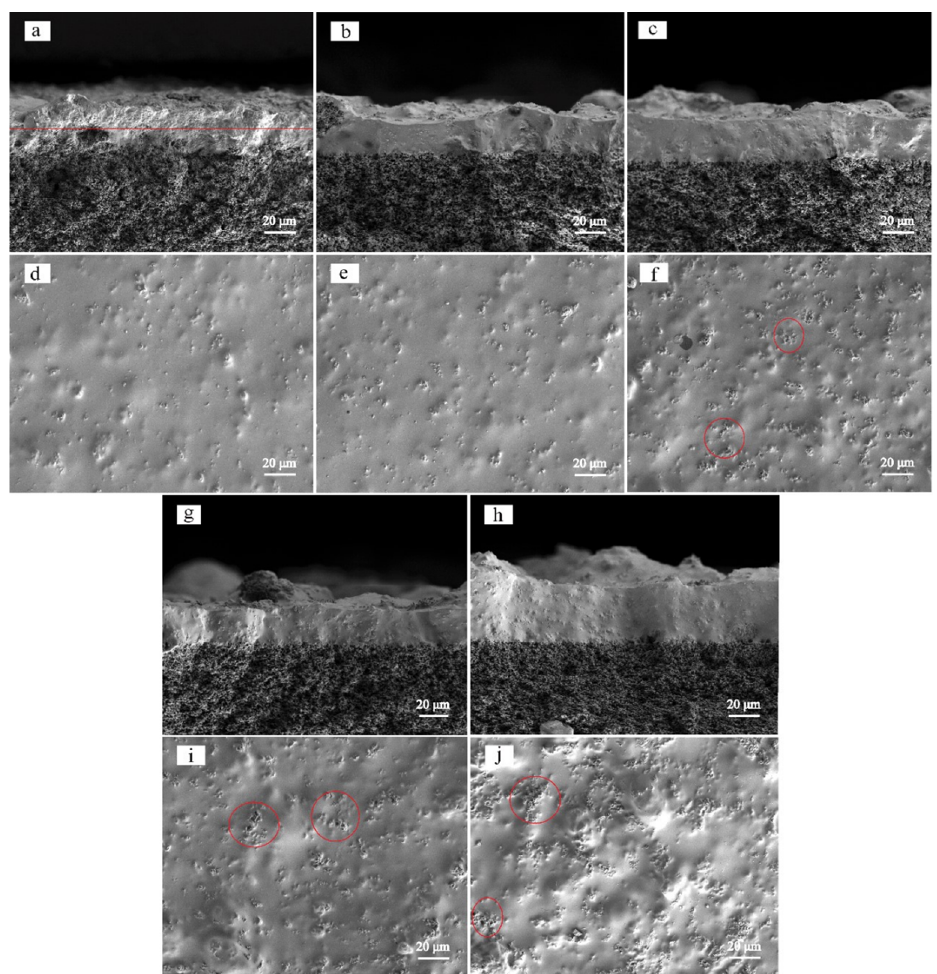
Figure 6. SEM images of the silicalite-1/PDMS/PVDF hybrid membranes with different zeolites con- tents: ( a , d ) 5% loading; ( b , e ) 10% loading; ( c , f ) 15% loading; ( g , i ) 20% loading; and ( h , j ) 30%